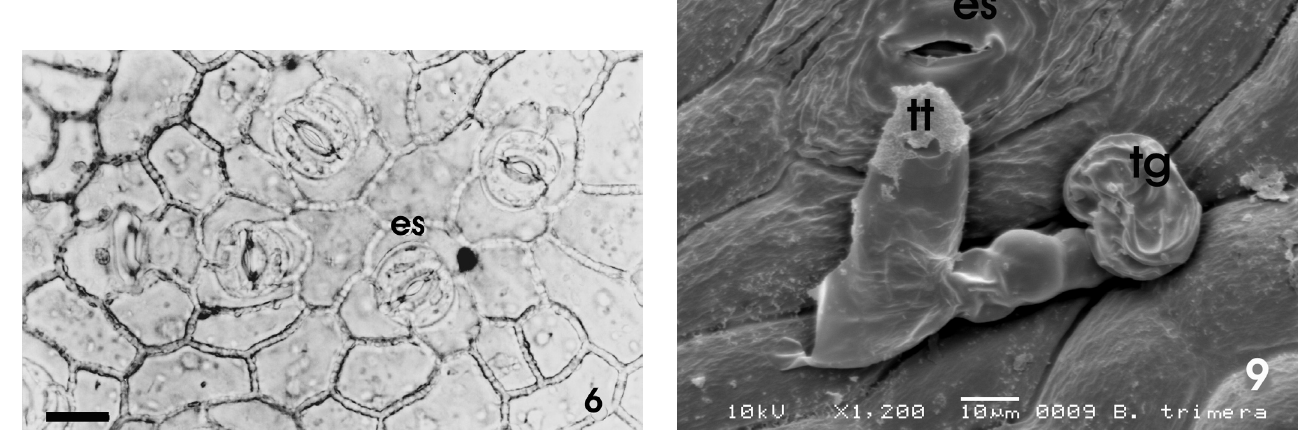
FIGURA 5 – B. microcephala – Vista frontal da epiderme da ala dos cladódios. es: estômato; tg: tricoma glandular; tt: tricoma tector. Barra = 20 µ m.